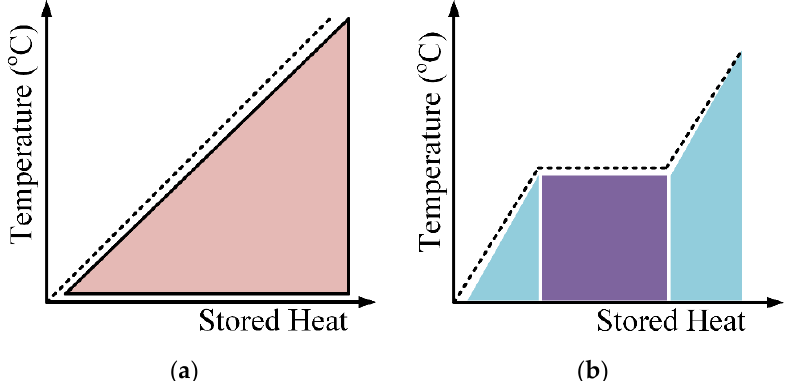
Figure 13. Two methods of storing thermal energy ( a ) sensible heat, which linearly rises the temperature of the body ( b ) latent heat, which changes the state of the body without rising its temperature